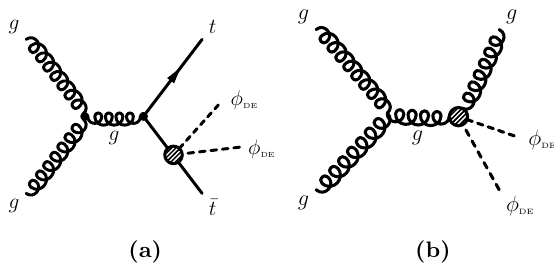
Figure 7. Schematic representation of representative production modes for the DE model for the Lagrangian e(cid:11)ective operators (a)